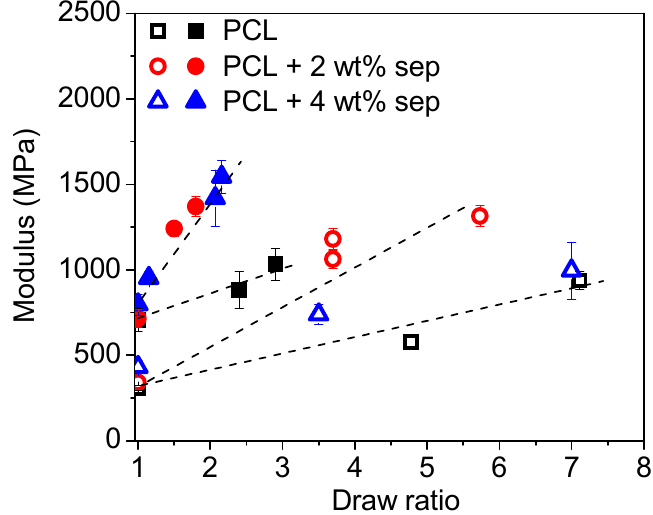
Figure 8. Young’s modulus as a function of draw ratio for samples cooled with open (open symbols) and closed (closed symbols) chill rolls. The dotted lines are added as a guide for the eye.